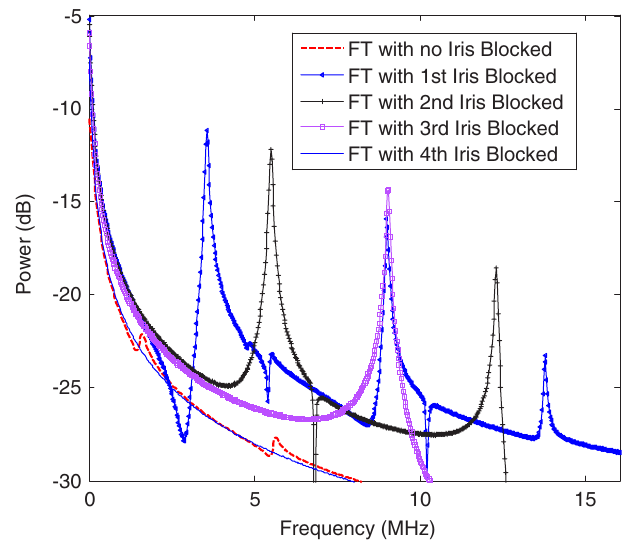
FIG. 5. (Color) Predicted frequency spectrum of the log of the probe power at the downstream end of the cavity when different irises are blocked and the cell fields are equal initially, except for the no iris blocked case, in which the first cell has a field 3% lower than the